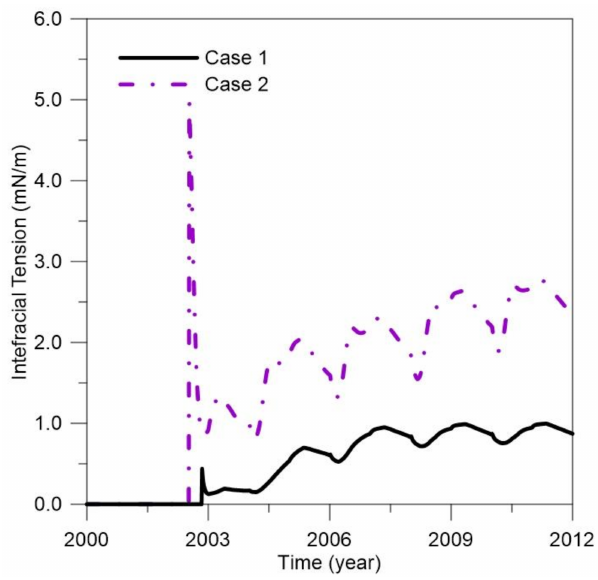
Figure 3. Interfacial tension between CO 2 -impure gas and the oil during CO 2 and impure CO 2 WAG